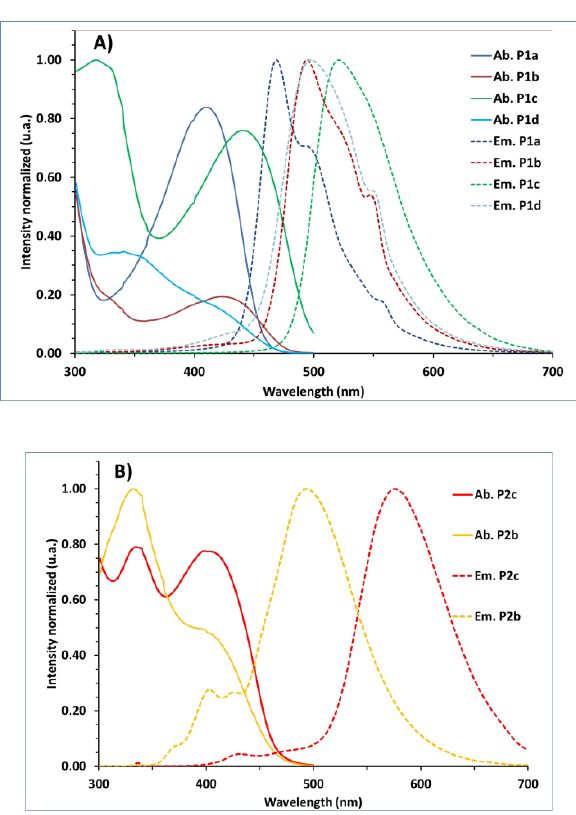
Figure 1. Normalized absorption (solid line) and emission (dashed line) spectra of P1 and P2 series at 298 K in chloroform, for ( A ): P1a – d and ( B ): P2b , c . All photoluminescence spectra were measured at maximum absorption peak of the